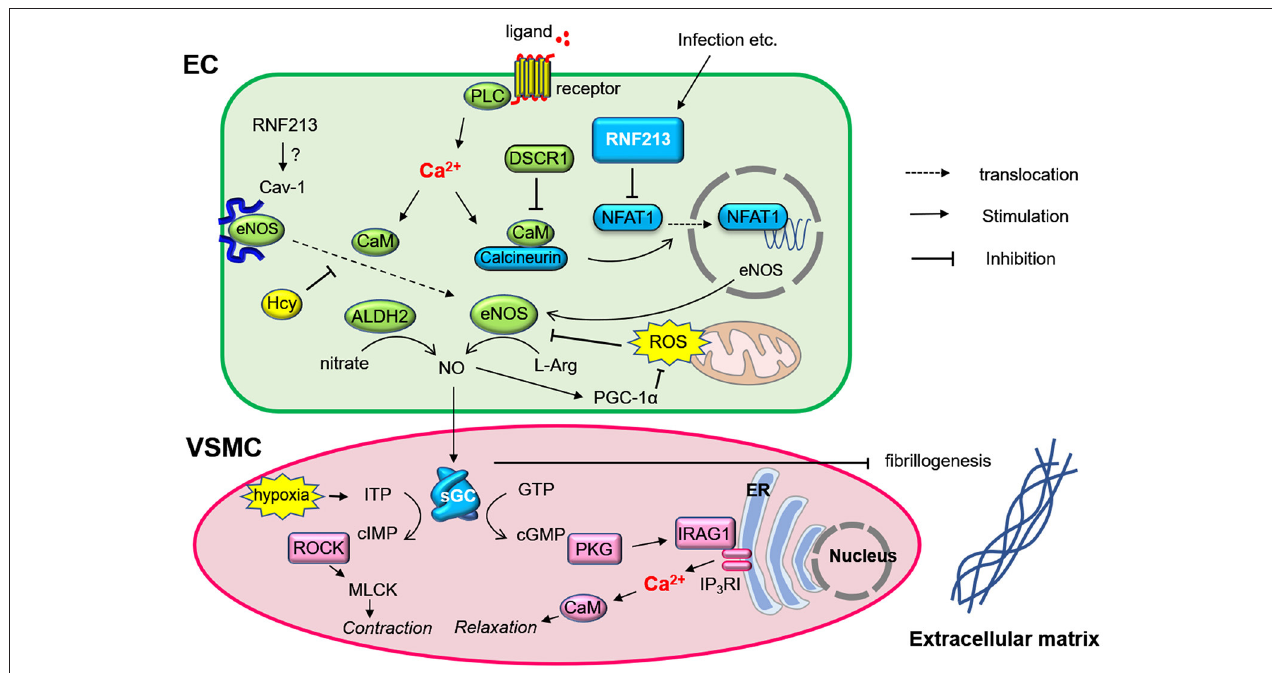
FIGURE 3 | Regulation of nitric oxide signaling by RNF213 (hypothetical role) and GUCY1A3 (sGC) in endothelial cells and vascular smooth muscle cells. Endothelial cell stimulation induces calcium-calmodulin-calcineurin signaling, which produces eNOS via NFAT1. RNF213 degrades NFAT1, which may regulate eNOS production. NO is synthesized from L-Arginin by eNOS and diffuses to vascular smooth muscle cells. NO is catalyzed by soluble guanylate cyclase (sGC), and cIMP or cGMP transmit signaling to induce vasodilatation. sGC also contributes to prohibiting fibrinogenesis. Many molecules known to be associated with moyamoya disease such as caveolin-1 (CAV1), Down Syndrome Critical Region 1 (DSCR1), inositol 1,4,5-Triphosphate Receptor Associated 1 (IRAG1) is involved in this molecular network. ALDH2, aldehyde dehydrogenase 2; CaM, calmodulin; cIMP, Inosine 3’, 5’-cyclic monophosphosphate; EC, endothelial cell; Hcy, homocysteine; ITP, inosine triphosphate; L-Arg, L-Arginin; MLCK, myosin light-chain kinase; PKD, protein kinase G; PGC-1 α , PPAR γ -coactivator-1 α ; PLC, phospholipase C; ROCK, Rho kinase; ROS, reactive oxygen species; VSMC, vascular smooth muscle